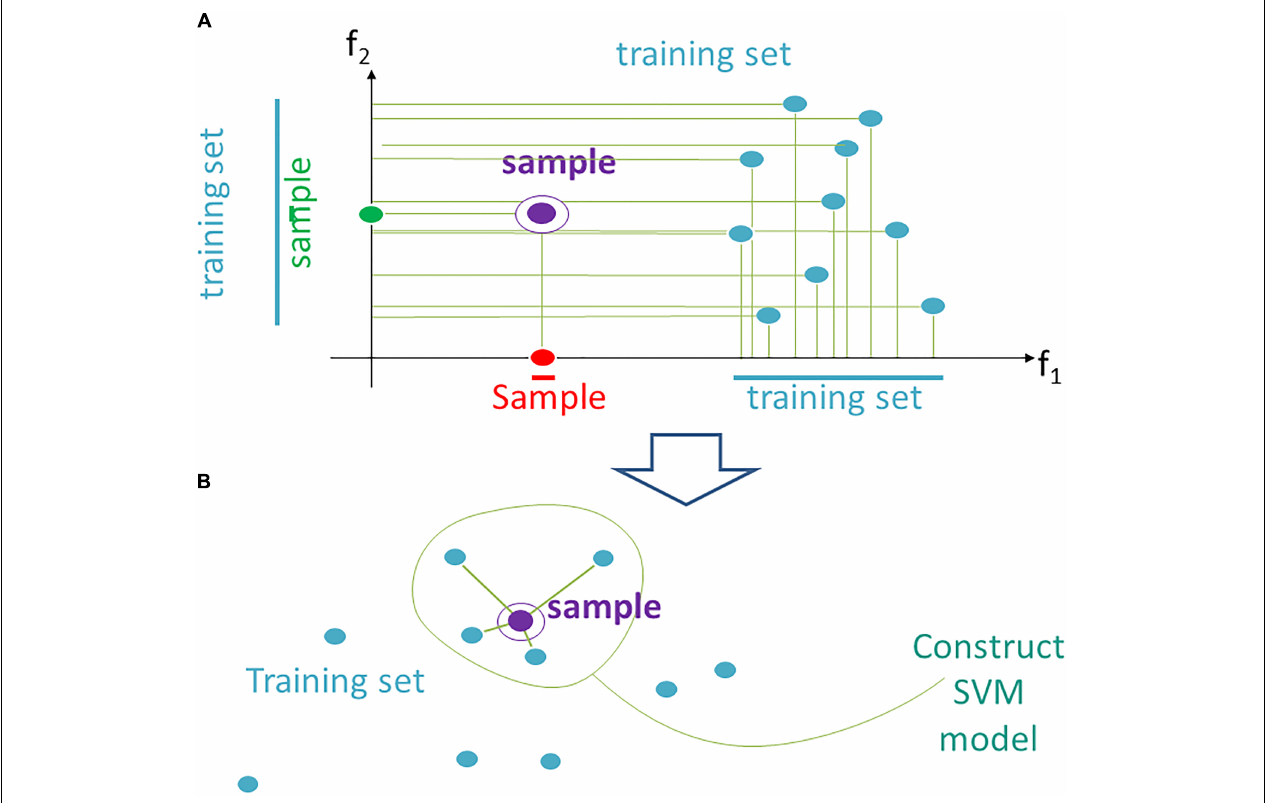
FIGURE 1 | Data trimming pipeline. (A) selection of relevant features in FloWPS according to the m -condition. A violet dot shows the position of a validation point. Turquoise dots stand for the points from the training dataset. The features (here: f 1 and f 2 ) are considered relevant when they satisfy the criterion that at least m flanking training points must be present on both sides relative to the validation point along the feature-specific axis. In the figure, it is exemplified that m -condition is satisfied for f 1 feature when m = 0 only, and for the f 2 , when m ≤ 5. (B) After selection of the relevant features, only k nearest neighbors in the training sets are selected to construct the SVM model. On the figure, k = 4, although k starting from 20 was used in our calculations, to build SVM